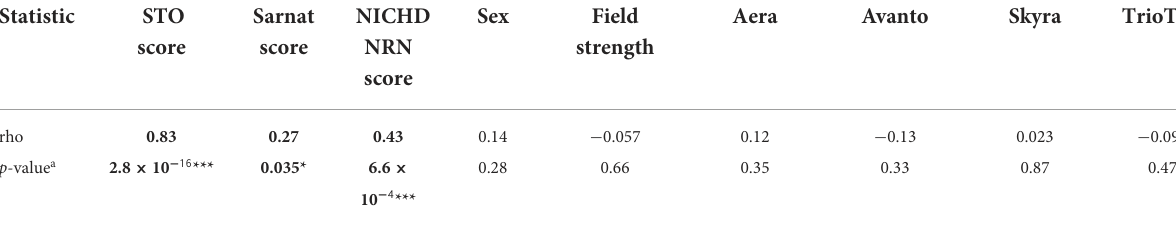
TABLE 5 Spearman’s correlation coefficients and p -values between the cDTI score and the categorical clinical variables.